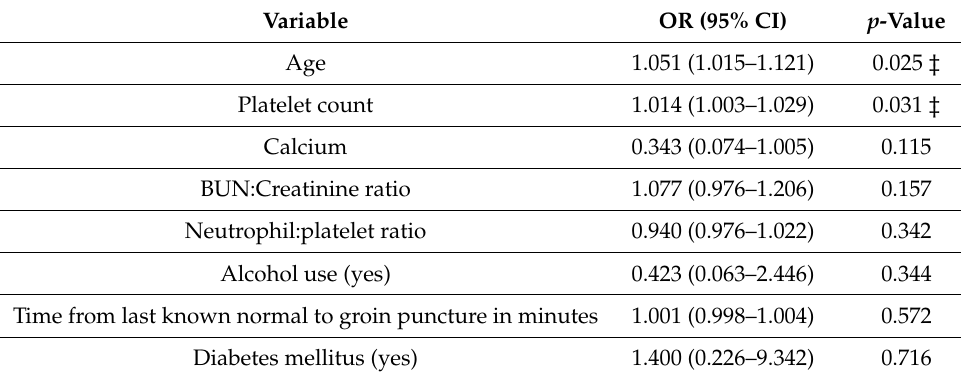
Table 2. Results of the multivariate logistic regression.